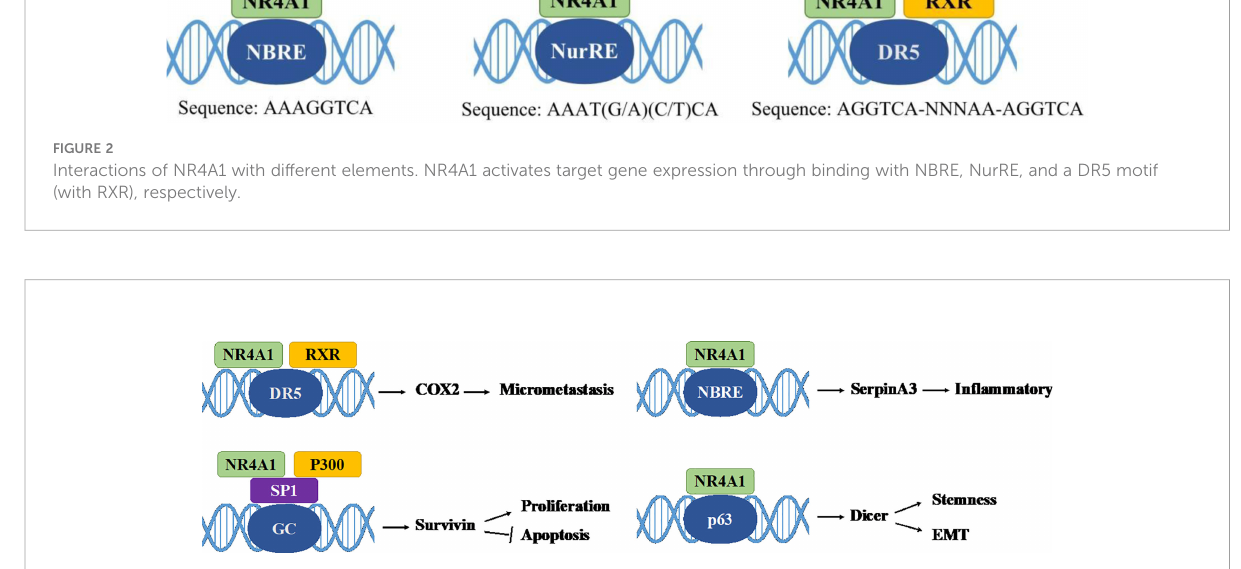
FIGURE 3 Some genomic effects of NR4A1. NR4A1 can bind to different genes promoter to involve in cancer progression. GC: GC-rich promoter regions of